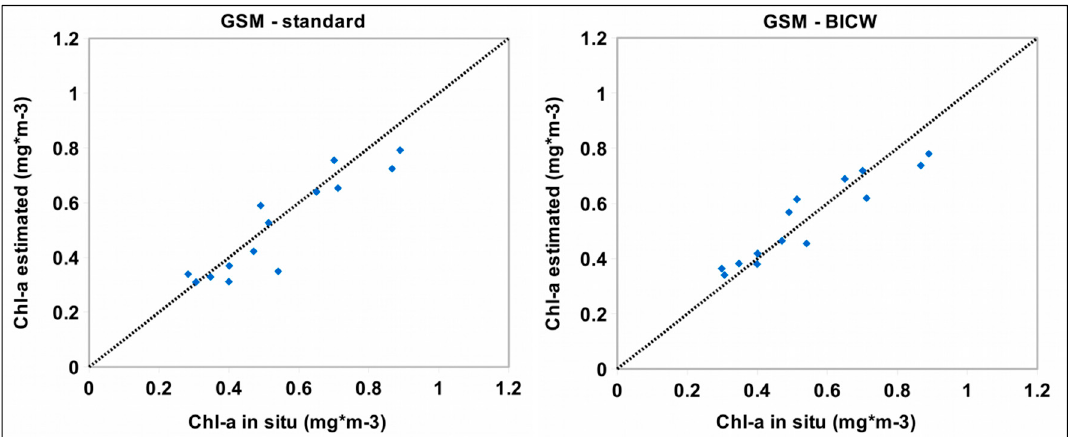
Figure 11. Scatter plots of in situ versus MODIS-A chl-a values for GSM-standard and GSM-BICW algorithms. In each plot, the dashed line is the 1:1 line. algorithms. In each plot, the dashed line is the 1:1